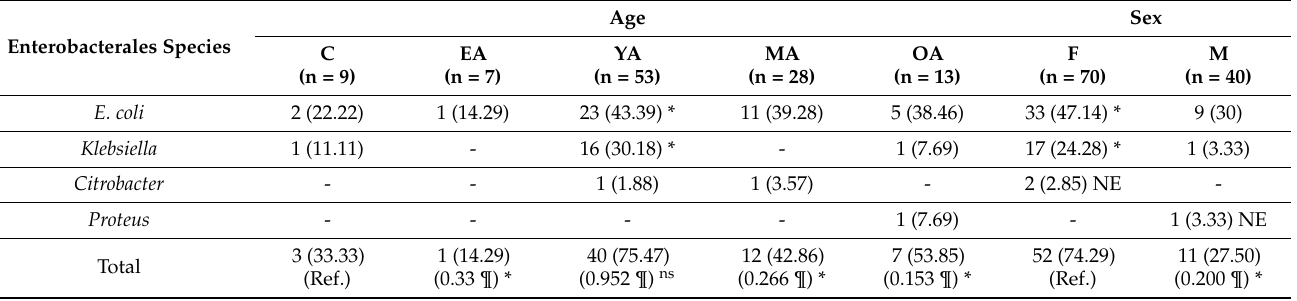
Table 1. Occurrence of Enterobacterales in human urine